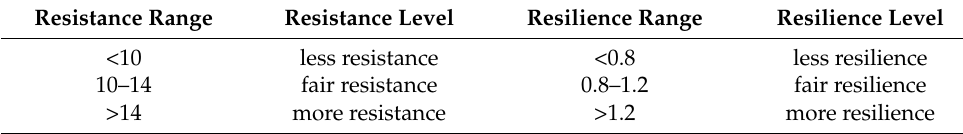
Table 1. Resistance and resilience levels